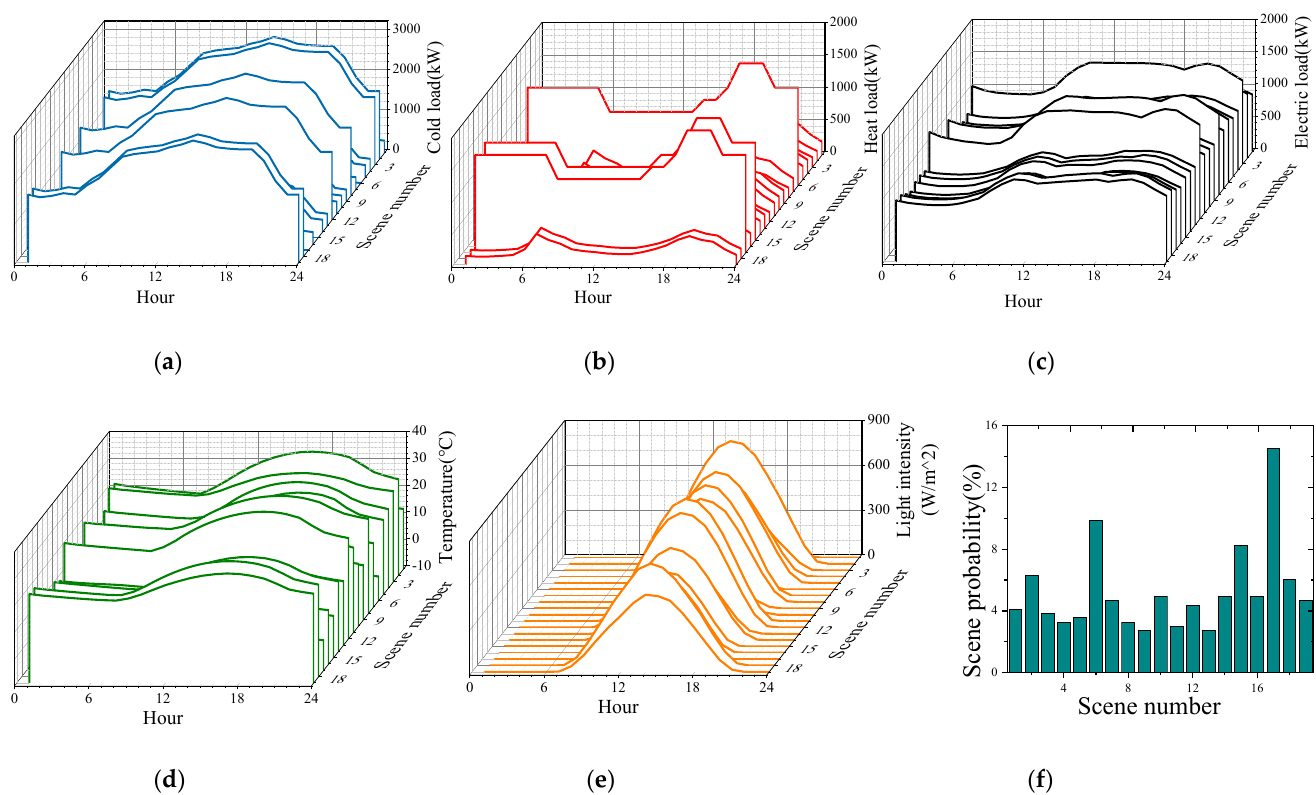
Figure 14. ( a ) Heat load clustering result based on FCM; ( b ) Heat load clustering result based on FCM; ( c ) Electric load clustering result based on FCM; ( d ) Temperature data clustering result based on FCM; ( e ) Light intensity data clustering result based on FCM; ( f ). Probability of each clustering scene.